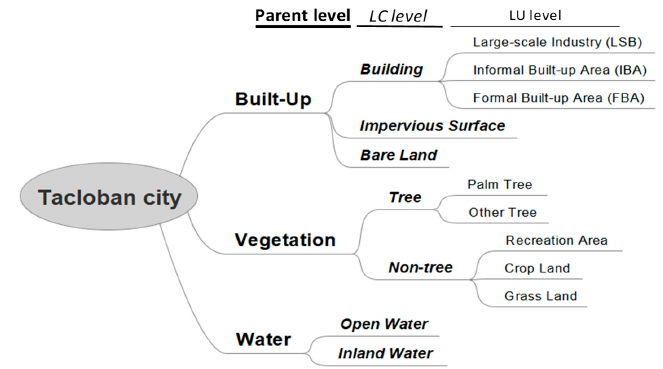
Figure 5. Hierarchy definition of LC and LU classes for test area Tacloban city.